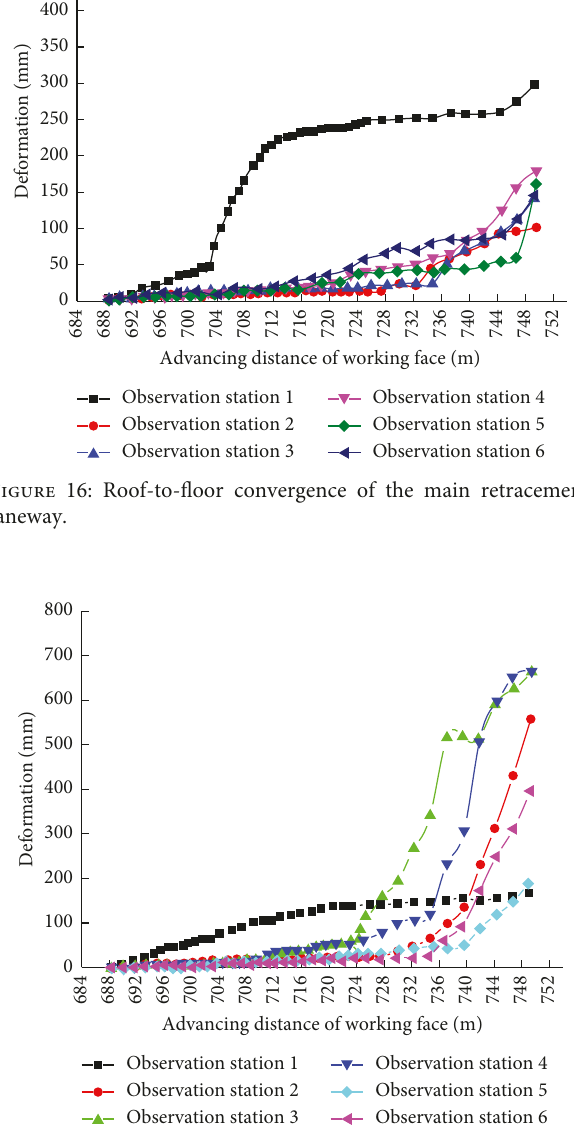
Figure 17: Wall convergence of the main retracement laneway.